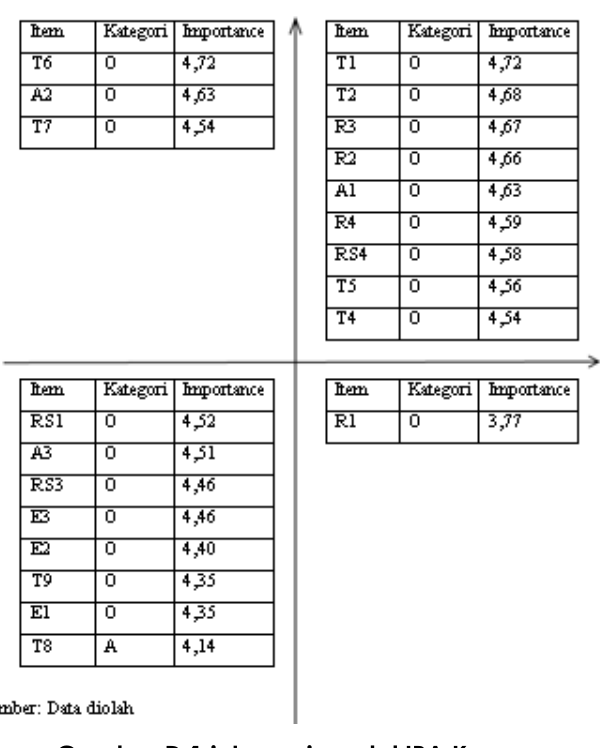
Gambar D.1 integrasi model IPA Kano Pembahasan Cause and Effect